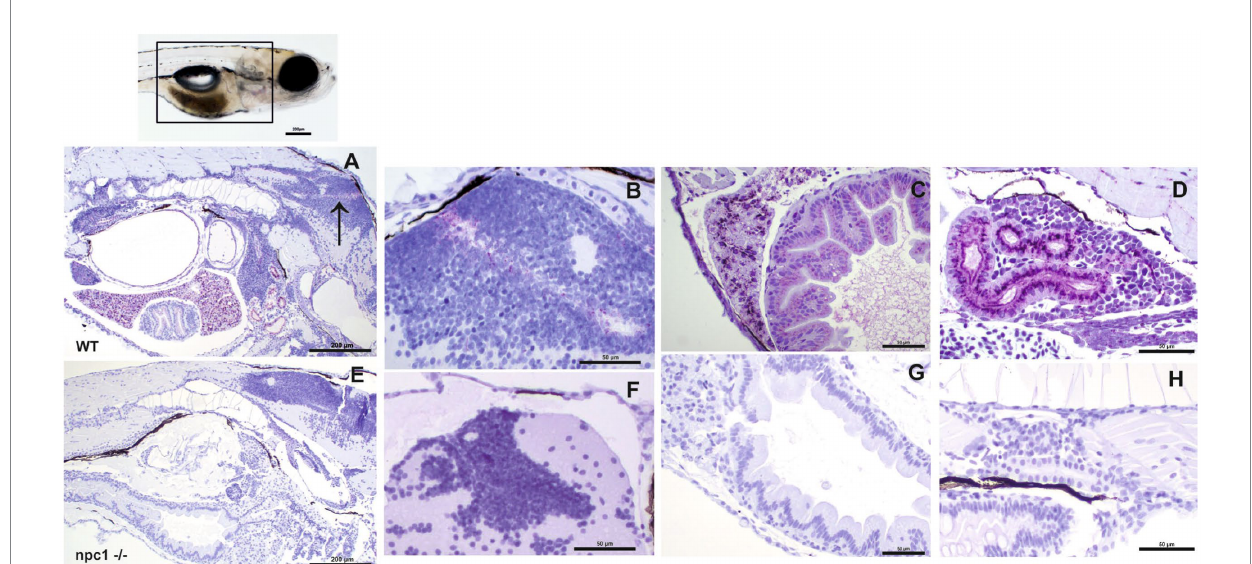
FIGURE 6 Immunohistochemical study at 3 wpf with anti-NPC1 antibody in wt (A–D) and npc1 − / − individuals (E–H) . The square in the top picture indicates the part of the body shown in (A,E) . Wt fish (A) were anti-NPC1 positive (indicated by purple staining) in the central nervous system (A) (arrow) and (B) , liver (C) , intestine (C) and renal tubules (D) whereas npc1 − / − larvae (E) showed no staining in central nervous system (F) , liver (G) , intestine (G) or renal tubules (H) . Scale bars in (A,E) 200 μ m. Scale bars in (B–D,F–H) 50 μ m.